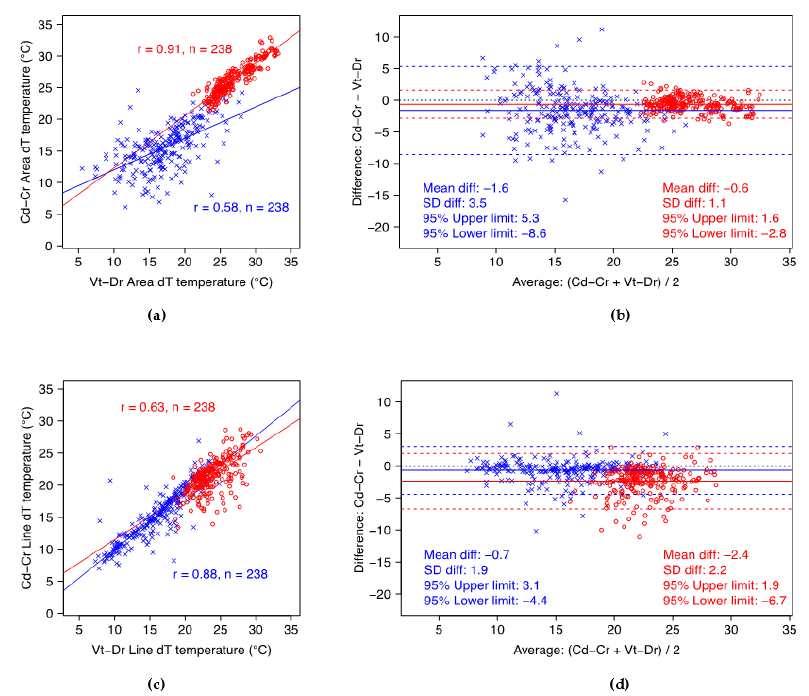
Figure 2. Scatterplots summarizing Pearson’s correlation ( r ) between projections (left side) and Bland–Altman plots (right side) for quarters (top row—( a , b )) and teats (bottom row—( c , d )) at 1st IRT. Cd-Cr—caudocranial projection; Vt-Dr—ventrodorsal projection; dT—temperature gradient; ∈ —‘min’ temperature gradient; o—‘max’ temperature gradient.